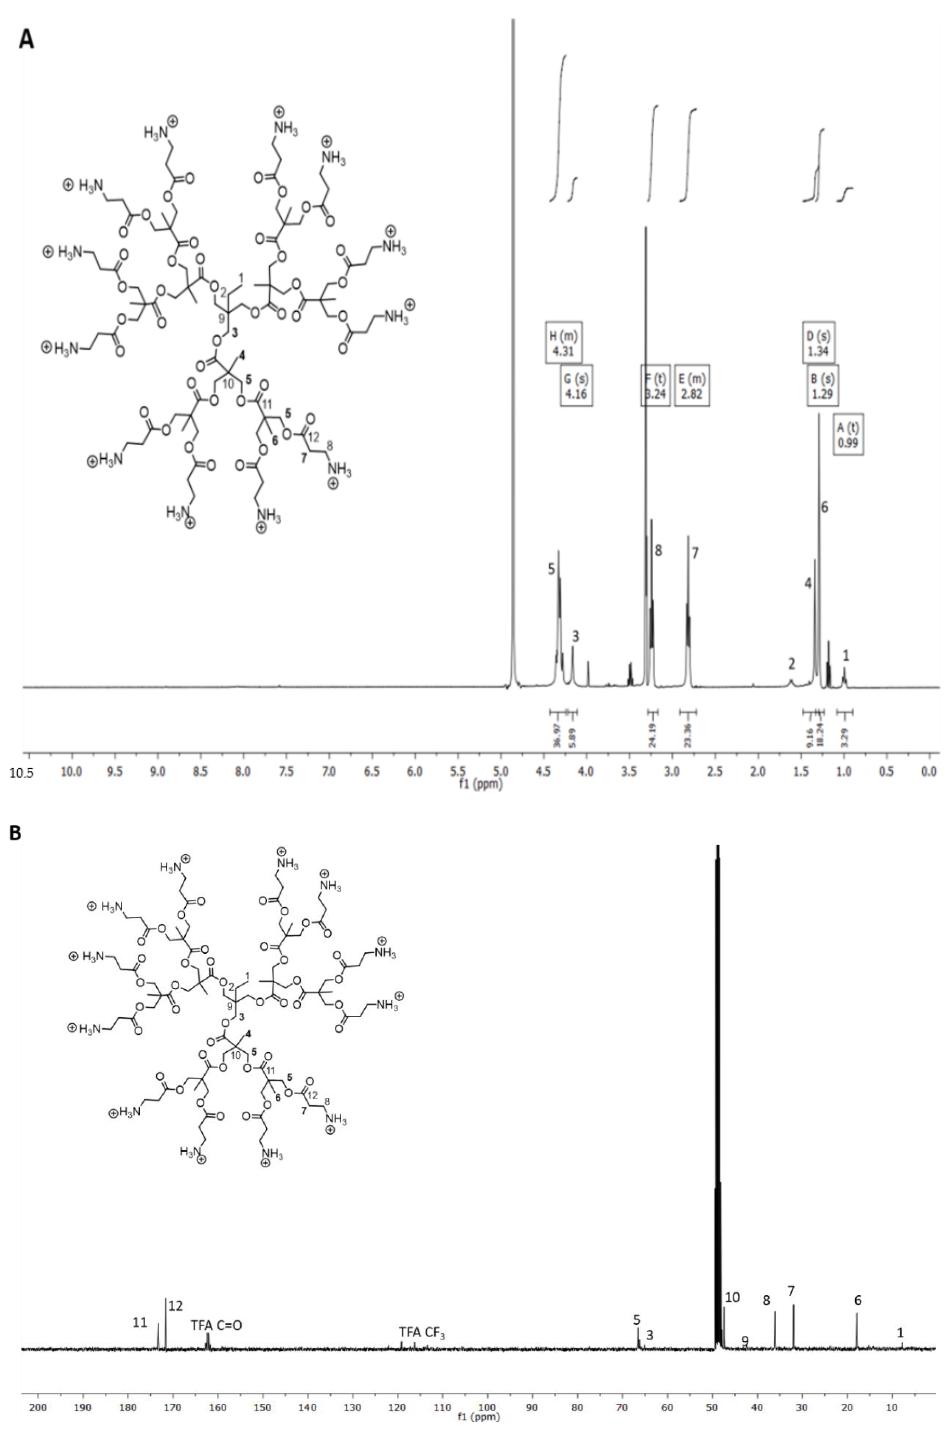
Figure 1. ( A ) 1 H NMR spectra of generation G2 showing the presence of β -alanine peaks at 3.24 ppm and 2.82 ppm. ( B ) 13 C NMR spectra of G2 showing the presence of β -alanine peaks at 36.07 ppm and 31.06 ppm in methanol-d 4 .